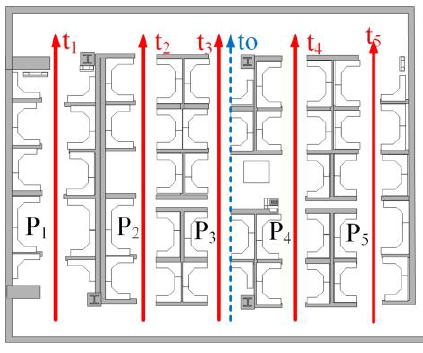
Figure 17. Spatial topology matching.